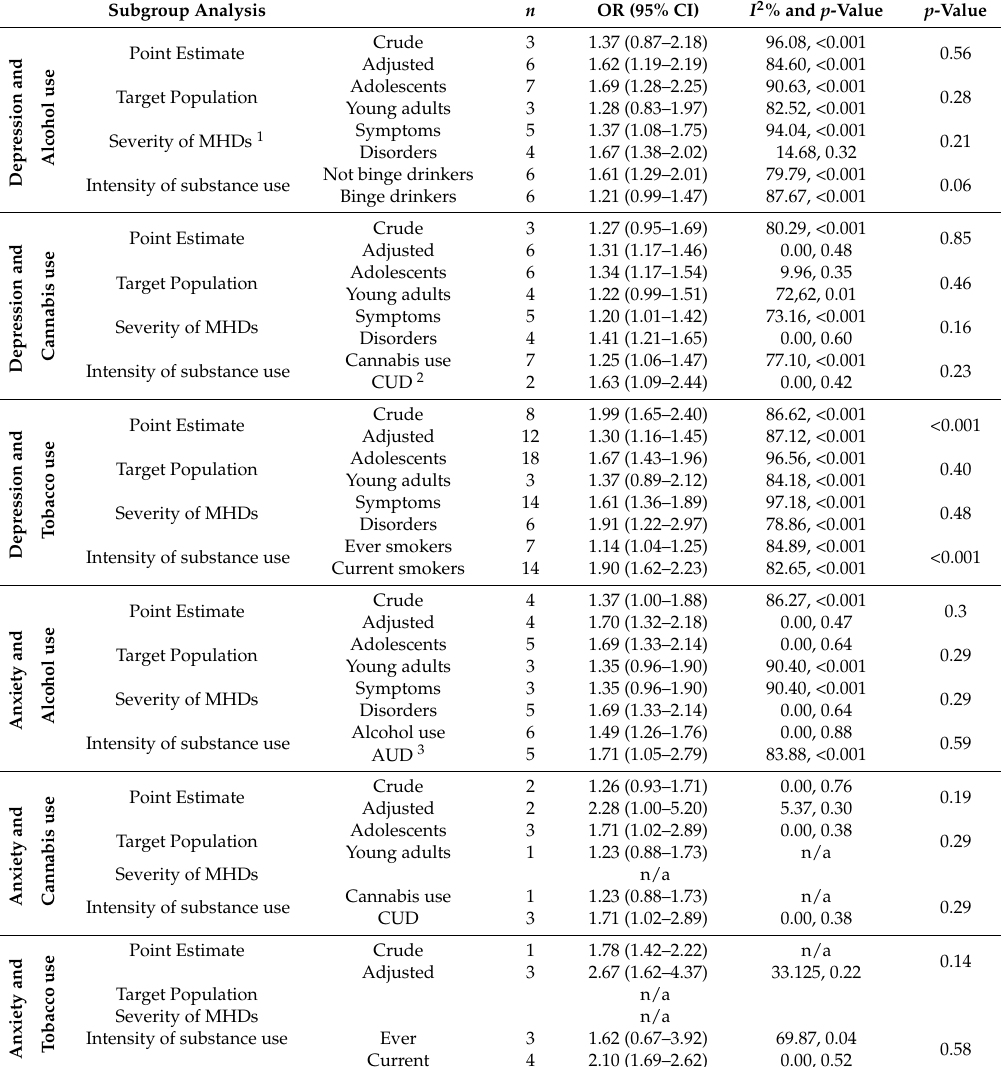
Table 3. Subgroup analysis for mental health disorders and substance